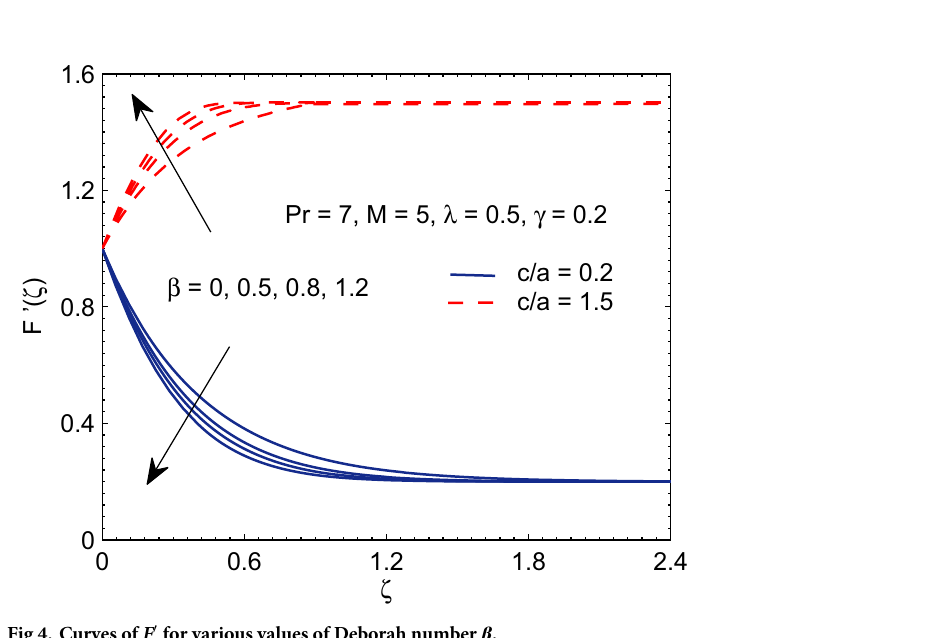
Fig 4. Curves of F 0 for various values of Deborah number β .